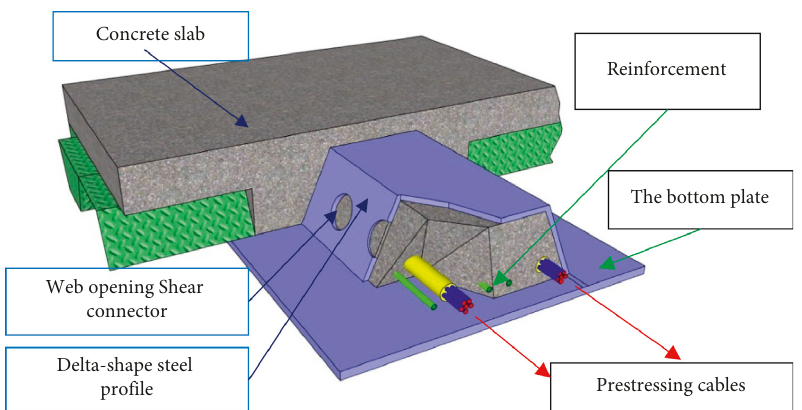
Figure 5: Composite slim floor beam with prestressing